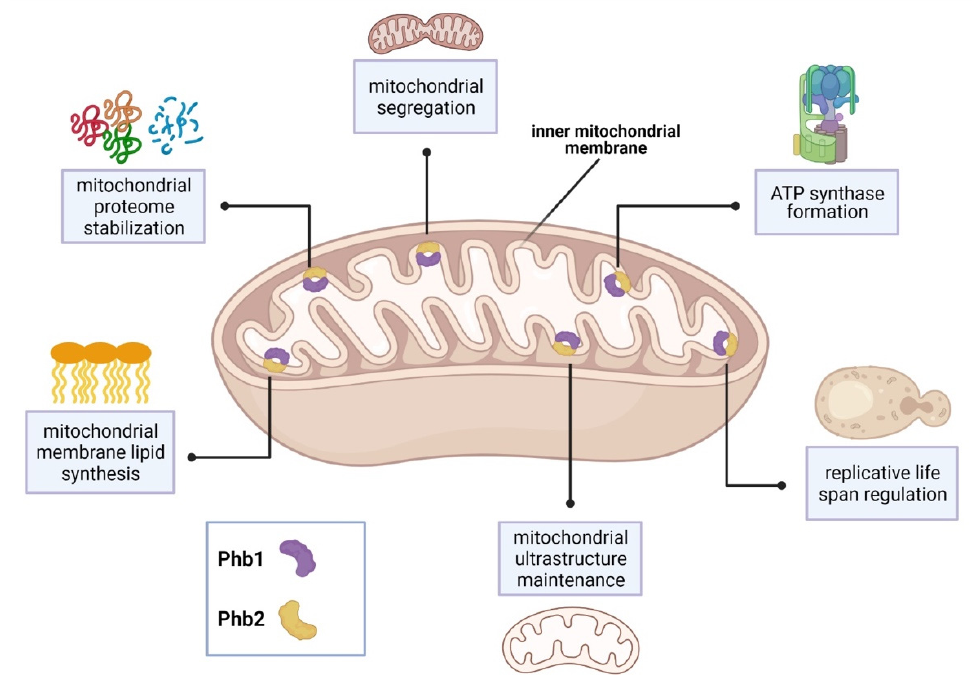
Figure 1. SPFH protein distribution and functions in S. cerevisiae . Phb1 and Phb2 form ring-shaped complexes that localize to the inner mitochondrial membrane. Known mitochondrial functions associated with the Phb1/Phb2 complex are depicted in the blue boxes. Figure adapted from references [9,34–37,39] and created with Biorender.com.